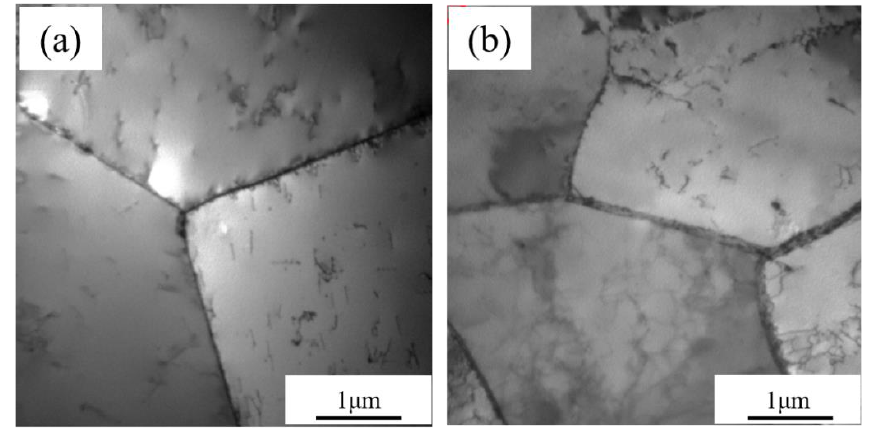
Figure 2. TEM bright-field micrographs of the Fe-Cr alloys before irradiation: ( a ) Fe-9Cr; ( b ) Fe-9Cr-C.